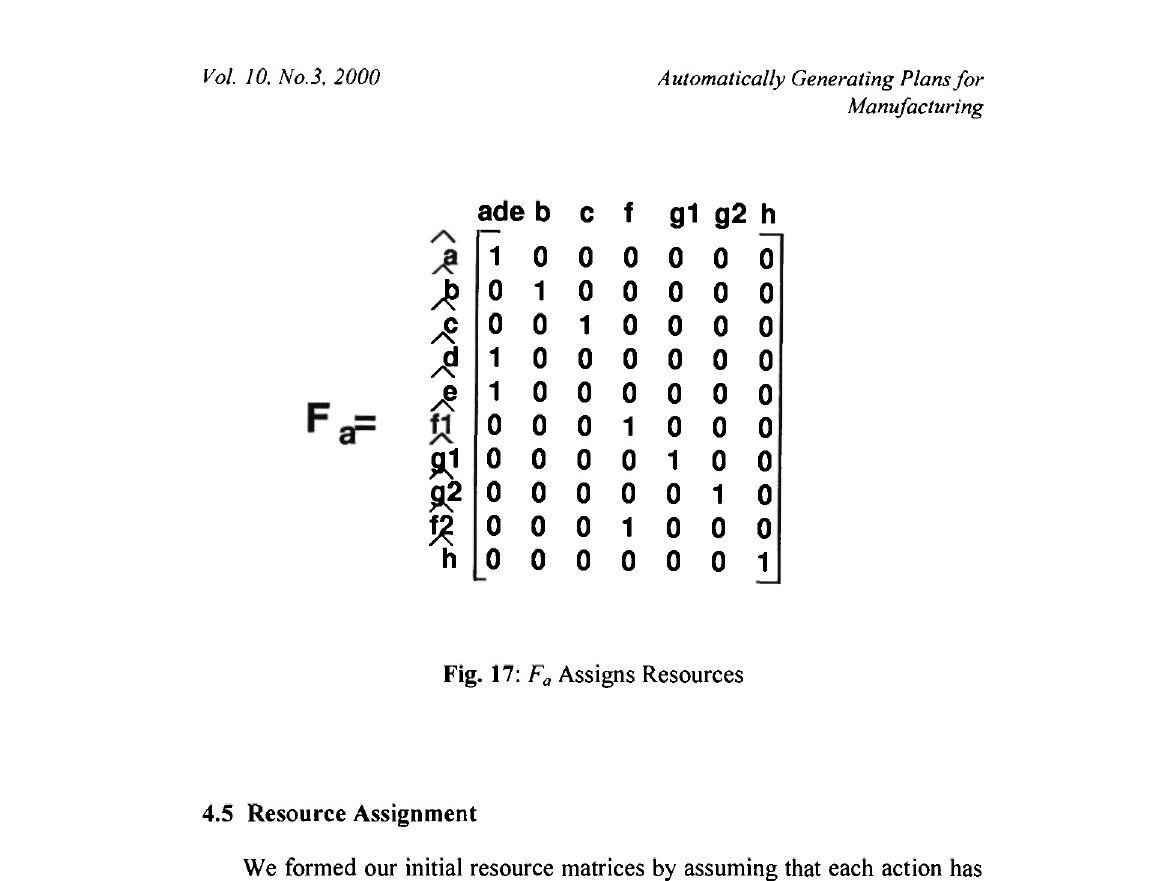
Fig. 17: F a Assigns